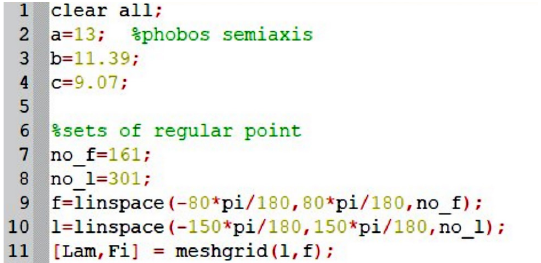
Fig. 2 Data input and generating the tables with planetocentric